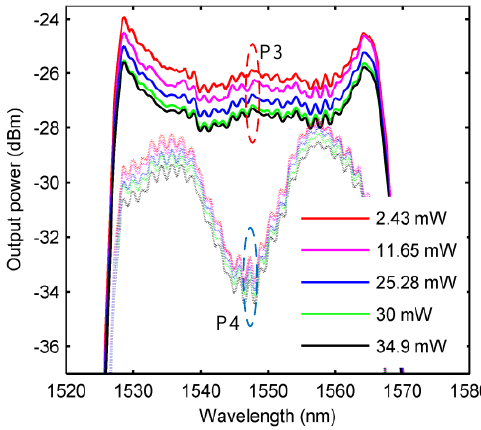
Figure 5. The all-optical modulation test results of the GOMC.